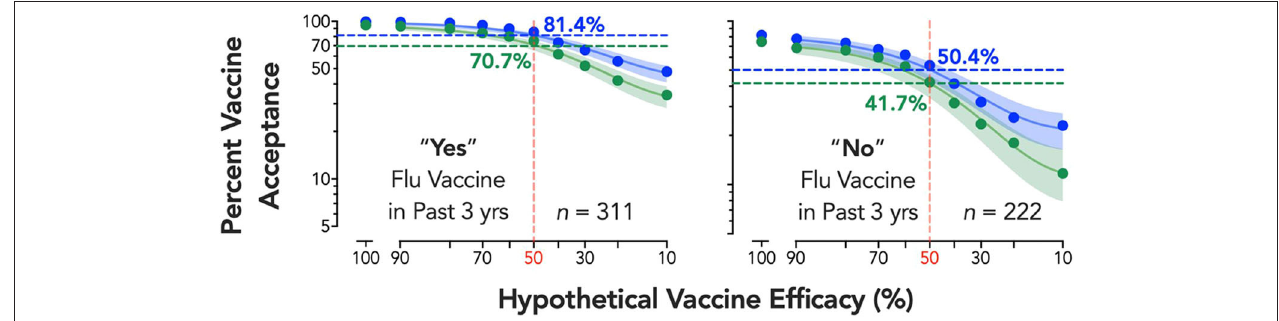
FIGURE 2 | Estimated percent vaccine acceptance by efficacy and vaccine development process for flu vaccine subgroup. Respondents reporting “Yes” (left panel) or “No” (right panel) to a question on whether they received the seasonal flu vaccine at least once in the past three years (data on seasonal flu vaccine receipt from one respondent was missing). Vertical reference lines (shaded red) depict the FDA’s 50% vaccine efficacy target, with horizontal lines depicting the vaccine acceptance associated with 50% efficacy for both standard (shaded blue) and expedited (shaded green) development processes; adjacent numerical values indicate exact solutions for coverage at 50% per group (shaded respectively). Shaded 95% confidence bands were generated using bias-corrected and accelerated (BCa) bootstrapped values based on 10,000 iterations. A corrected (for small numbers of data points) Akaike information criterion test indicates a > 99.99% probability the curves are best described independently (i.e., do not share best fit parameters in the nonlinear curve-fitting).